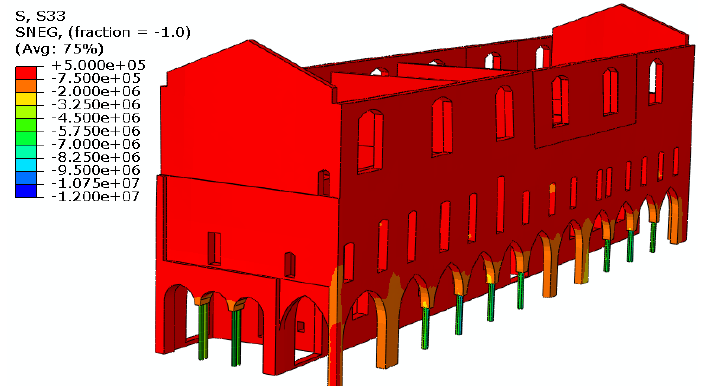
Figure 8. Vertical stress state (expressed in [N/m 2 ]) in the longitudinal façade induced by the self weight of the